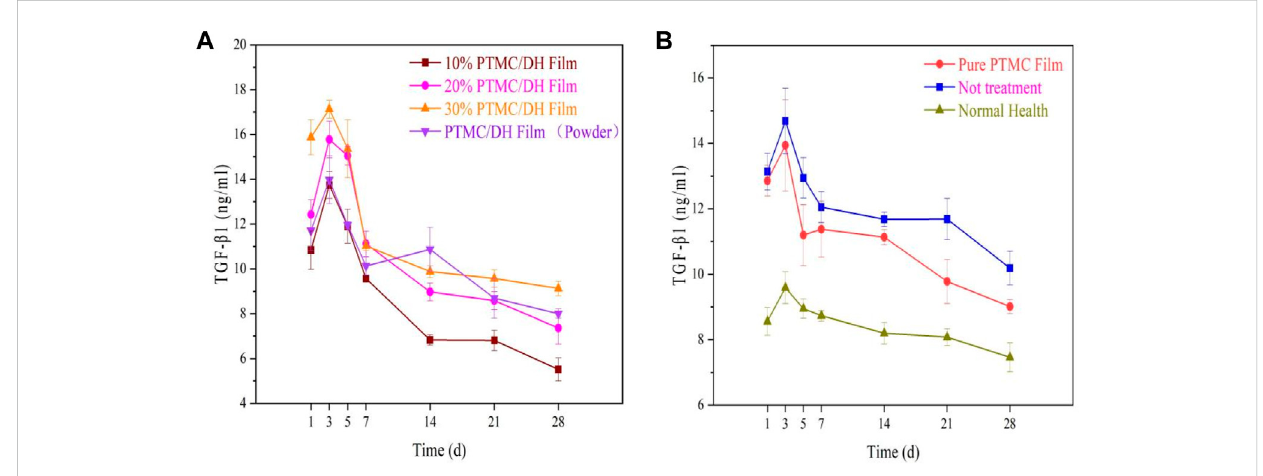
FIGURE 14 (A) TGF- β 1 trend in the experimental group over 28 days; (B) TGF- β 1 trend in the control group, blank group and normal healthy